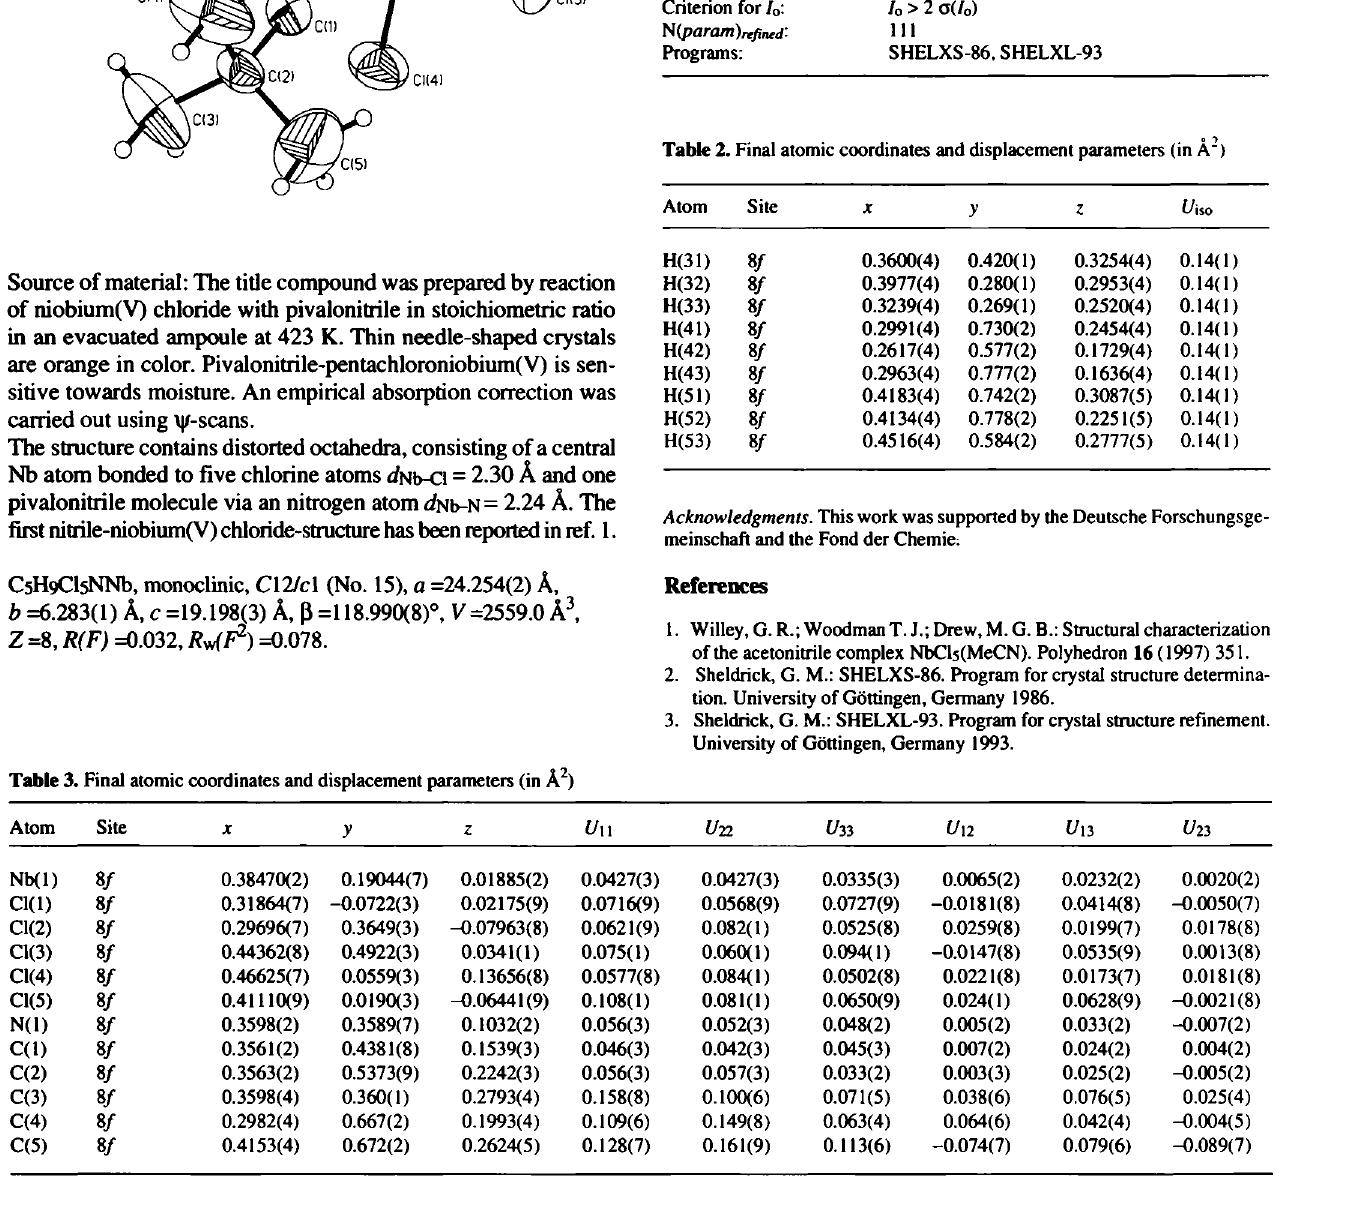
Table 2. Final atomic coordinates and displacement parameters (in